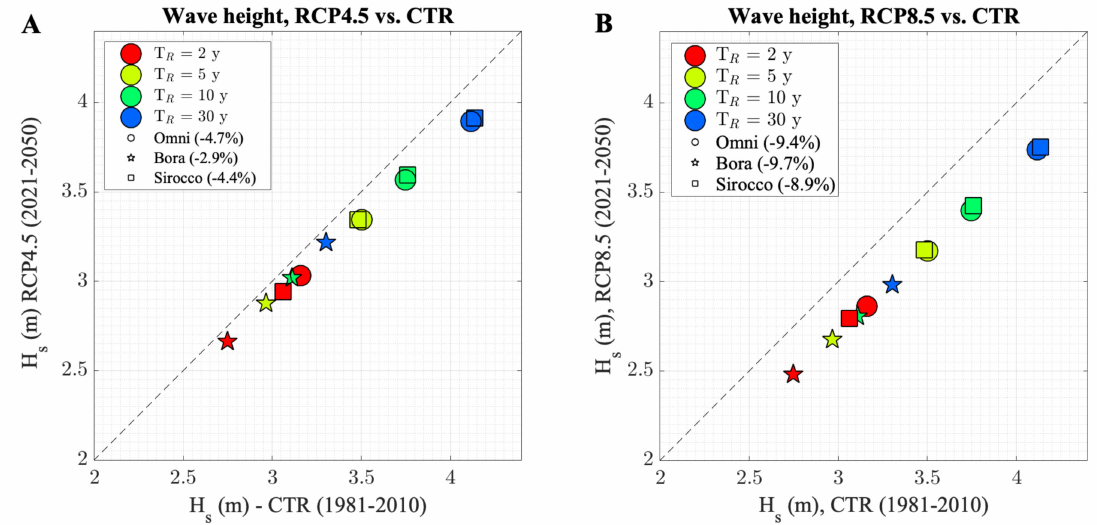
Figure 15. The long-term wave climate change offshore of the Venice lagoon (the northern Adriatic Sea, Malamocco inlet) for the projected future years 2021–2050. Comparison between the values of the significant wave height H s at different return periods T R (2, 5, 10, and 30 years) from the present-day simulation (CTR, 1981–2010) and the two scenarios RCP4.5 ( A ) and RCP8.5 ( B ). The statistics are provided for omnidirectional (circles), Bora (pentagram) and Sirocco (squares) sea states. The percentage values in the insets represent the average change for the future period. The dashed black line indicates the perfect 1:1 match between